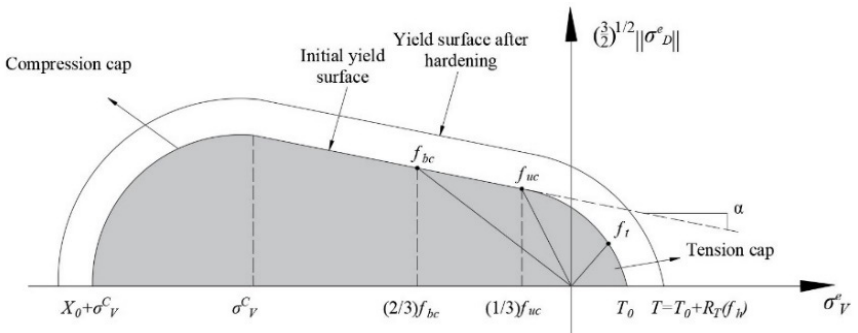
Figure 3. Smooth three-surface microplane cap yield function.